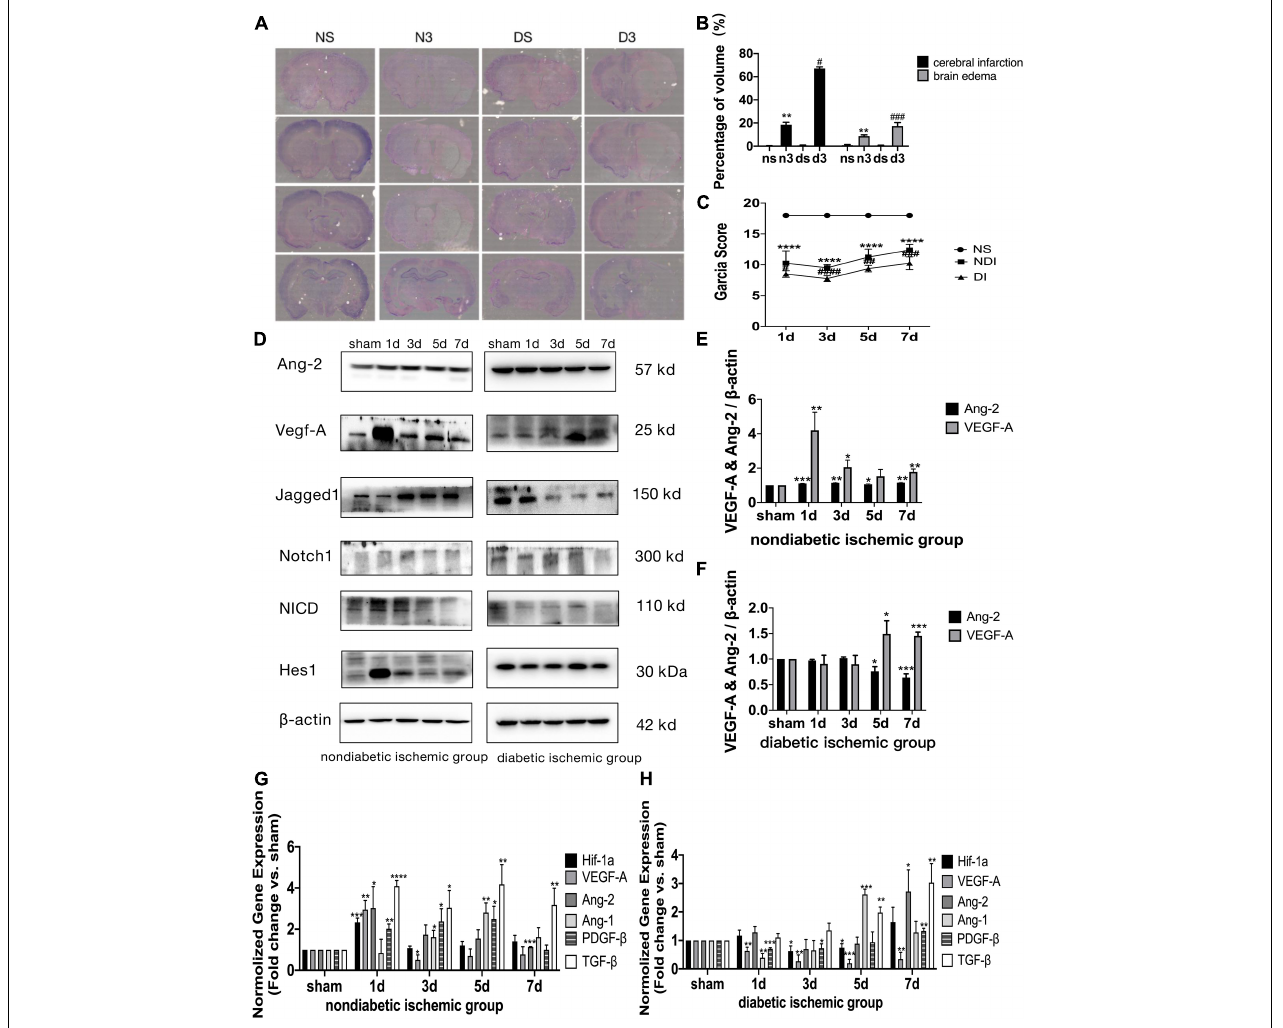
FIGURE 3 | Delayed angiogenesis after acute ischemic stroke in T2DM. (A) Cresyl violet (CV) staining on day 3. NS, non-diabetic sham group (Day 3); N3, non-diabetic cerebral ischemic group (Day 3); DS, diabetic sham group (Day 3); D3, diabetic cerebral ischemic group (Day 3). The unstained area was the infarction area. (B) The volume of cerebral infarction and brain edema was calculated by CV staining on day 3. (C) Garcia score was evaluated on D1–D7 after cerebral ischemia ( n = 8 per group). (D) The expression of VEGF-A, Ang-2, Jagged1, Notch1, NICD, and Hes1 in ischemic penumbra was assessed by Western blot ( n = 3 per group). (E,F) The expression of VEGF-A and Ang-2 protein were calculated in NDI group and DI group. (G,H) The gene expression of Hif-1a, VEGF-A, Ang-2, Ang-1, TGF- β , and PDGF- β was showed in NDI group and DI group. * p < 0.05 vs. sham group, ** p < 0.01 vs. sham group, *** p < 0.001 vs. sham group, **** p < 0.0001 vs. sham group; # p < 0.05 vs. NDI group, ## p < 0.01 vs. NDI group, ### p < 0.001 vs. NDI group, #### p < 0.0001 vs. NDI